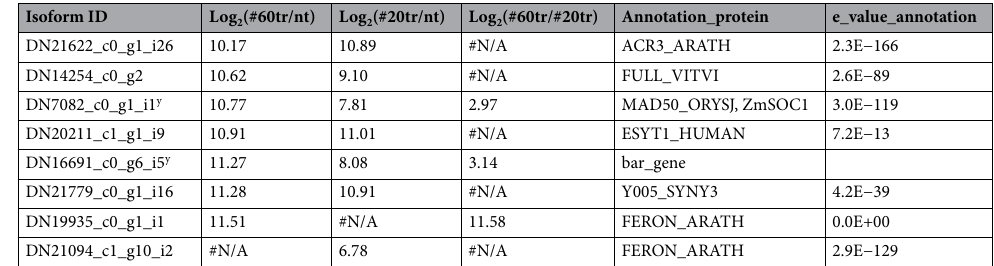
Table 2. Differentially expressed genes (DEGs) overlapped in two transgenic lines (#20tr and #60tr), each compared to the nontransgenic line. #N/As represent a non-DEGs. z The transcript verified by RT-qPCR. y Transgenes.